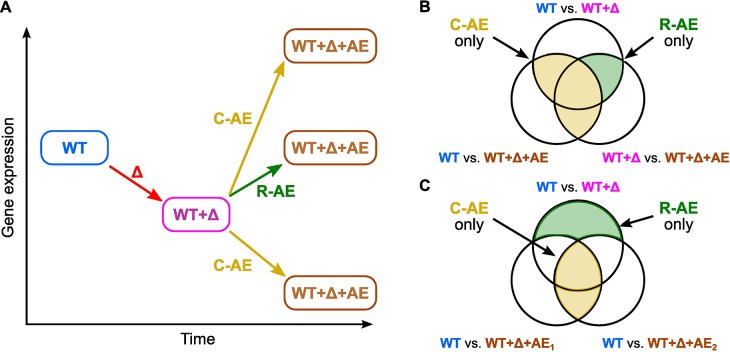
Restorative versus compensatory adaptive transcriptional responses to a deletion.(A) Illustration of the expression of a gene for the WT strain, the deletion strain, and the adaptively evolved (AE) strain for the two possible transcriptional responses: restorative adaptive evolution (R-AE), in which AE restores expression to that of the WT strain, and compensatory adaptive evolution (C-AE), in which the resulting expression is distinct from that of the WT strain. This classification applies to all genes whose expression is significantly perturbed by the gene deletion and/or the AE. (B, C) Venn diagrams indicating the sets of R-AE (green) and C-AE (yellow) genes. The diagram compares gene expression in the WT strain with that of the primary deletion and associated evolved strains, where each circle represents the set of genes exhibiting changes between the pair of strains marked next to it. In (B), all comparisons are for a single run of adaptive evolution and indicate the R-AE and C-AE genes for the resulting sup strain. In (C), comparisons are shown for two runs of AE, and the shaded regions mark genes that undergo R-AE and C-AE for both sup strains.